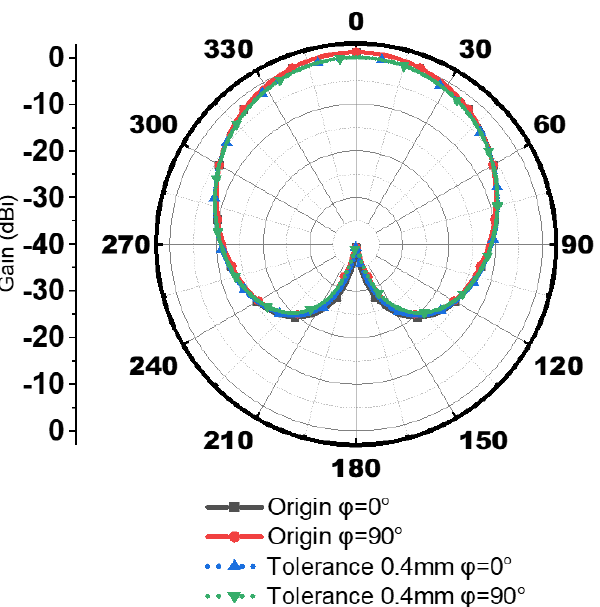
Figure 14. Normalized radiation patterns of original element and element with feeding structures’ movement.